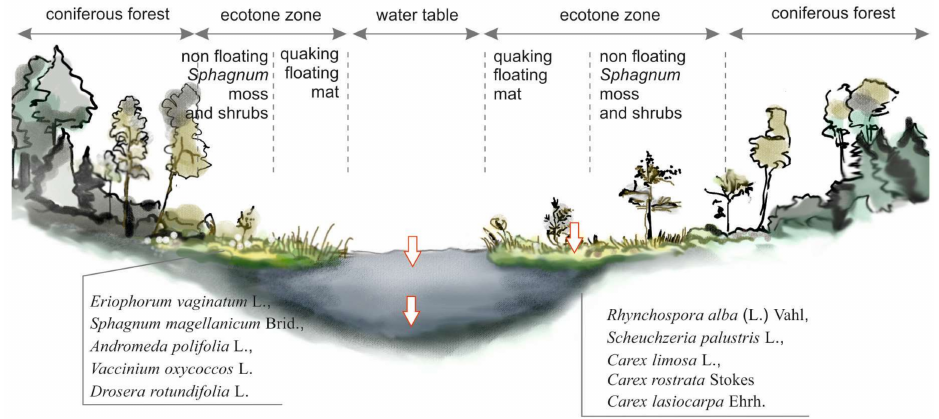
Figure 2. Crossection of a peat bog lake with the ecotone zone surrounding the water body. White arrows indicate sampling